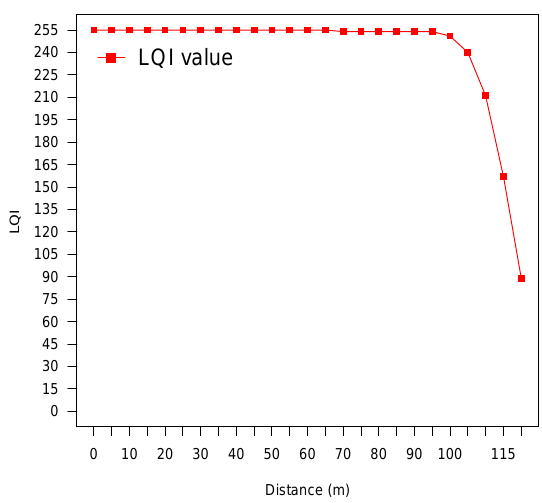
Figure 7. LQI vs distance without interference (2